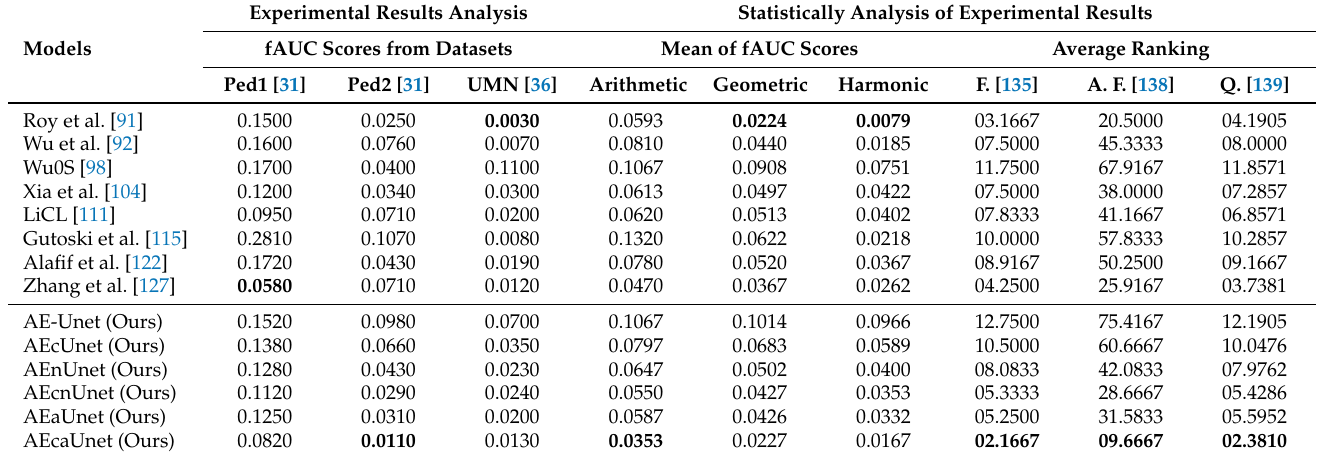
Table 11. Multiple comparison test for G 6 using fAUC. Column-wise the best numerical result is shown in bold .